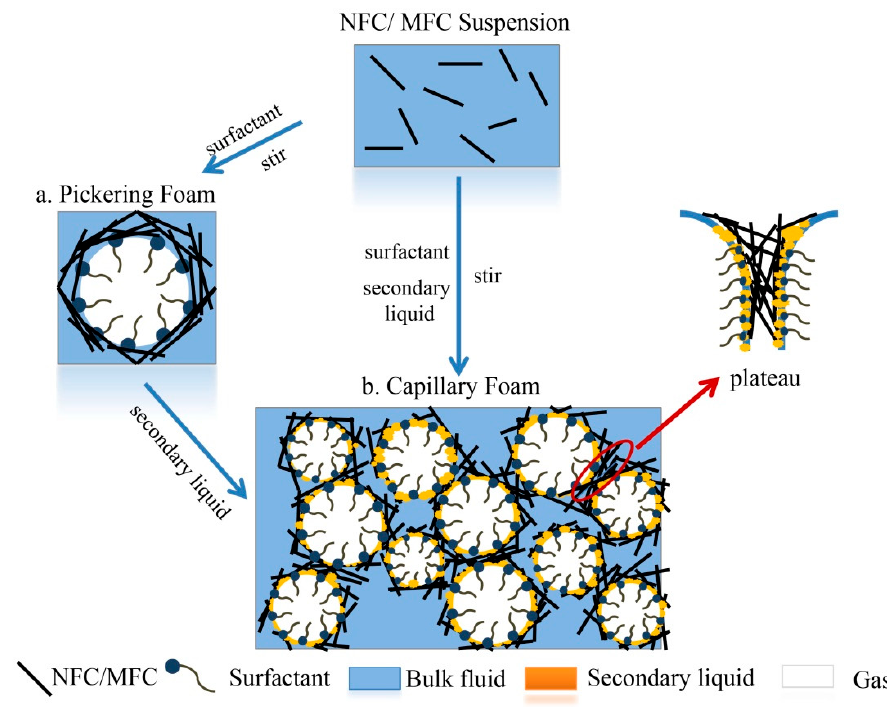
Figure 5. The stabilization mechanism of wet foam: ( a ) the structure of Pickering foam; ( b ) the structure of capillary foam.